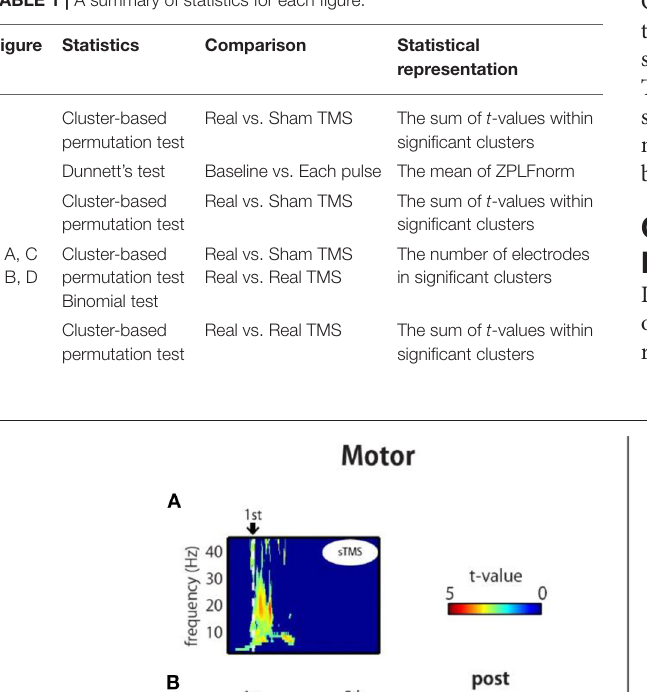
Frontiers in Human Neuroscience |